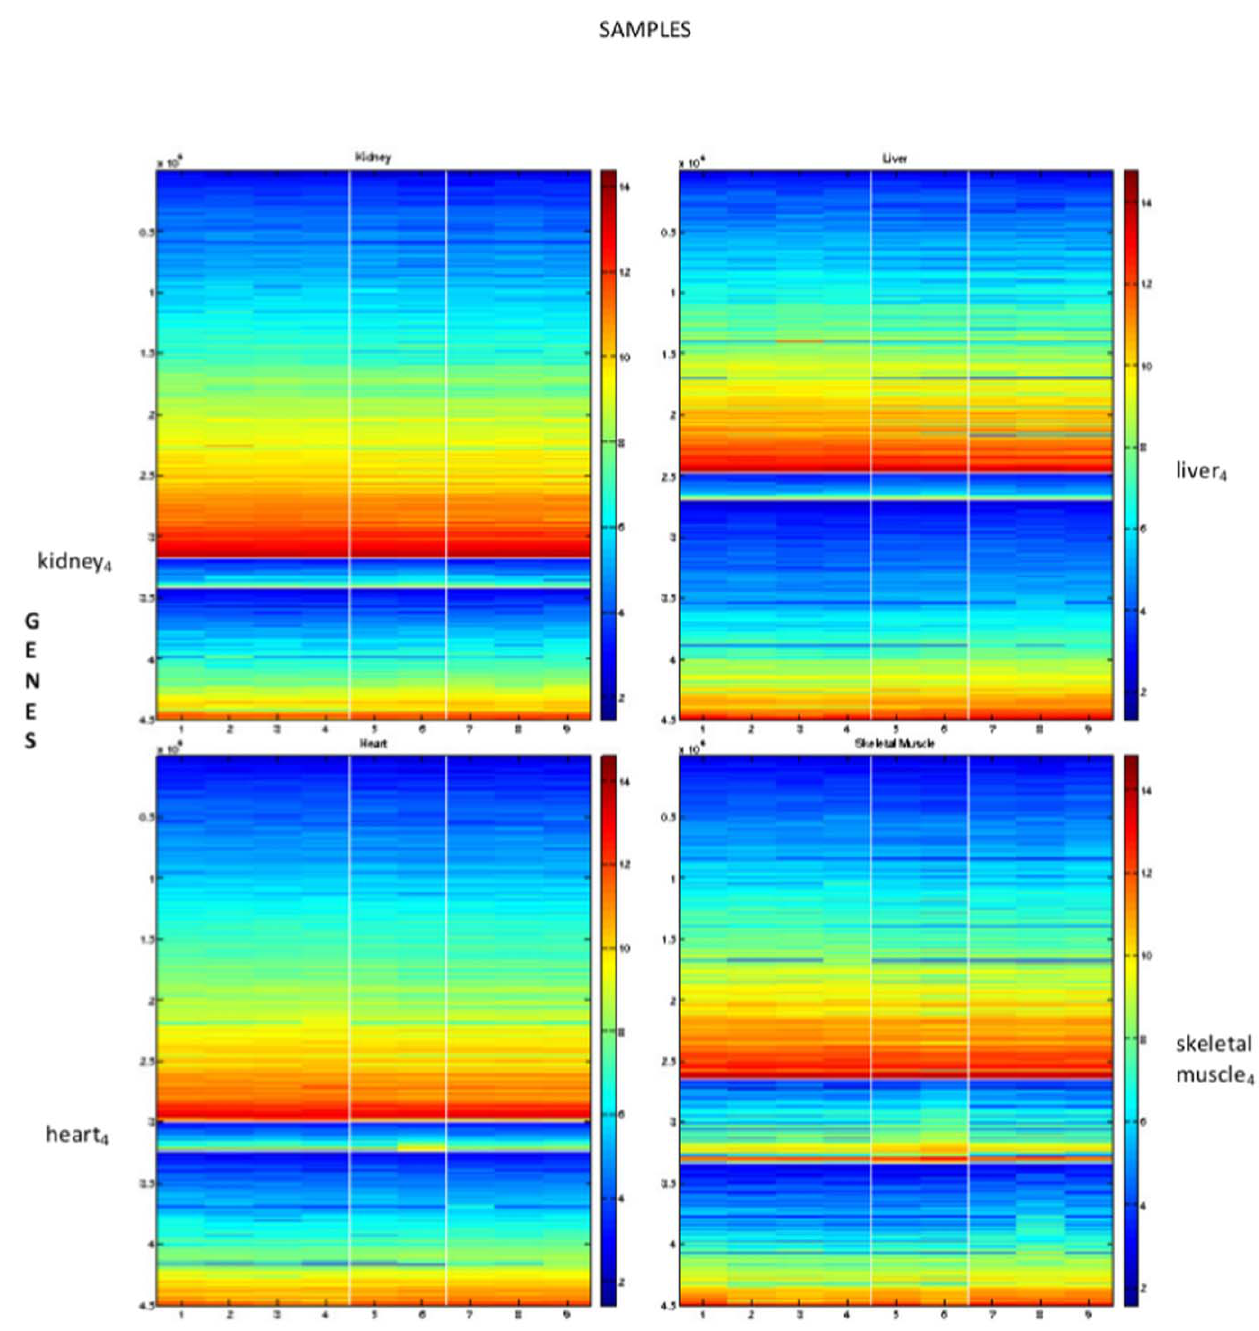
Figure 5. Factorisation of the four separate tissue types using simultaneous NMF with k ~ 3 . Top left, kidney; top right, liver; lower left, heart; lower right, skeletal muscle. The four tissue types are treated as separate sources of information across a common set of mice. Genes are therefore ordered differently in each of the four tissues, but the mice ordering is global. The resulting mouse ordering and mouse clusters are detailed in Table